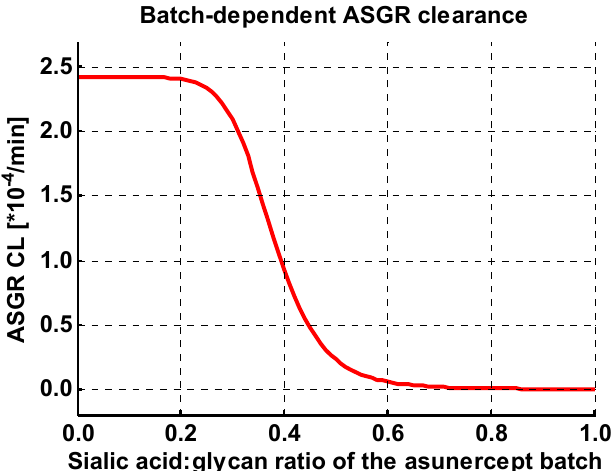
Figure 2. Asialoglycoprotein receptor (ASGR) mediated clearance of asunercept as a function of the sialic acid:glycan ratio of the different asunercept batches. This correlation was identified in a previously conducted nonlinear mixed effects modeling analysis [11] and implemented into the PBPK model. The clearance via ASGR is of no relevance for highly sialylated batches of asunercept with sialic acid:glycan ratios >0.6. Table 2. Drug-dependent parameters of the final PK-Sim asunercept protein model. Parameter Reference Description